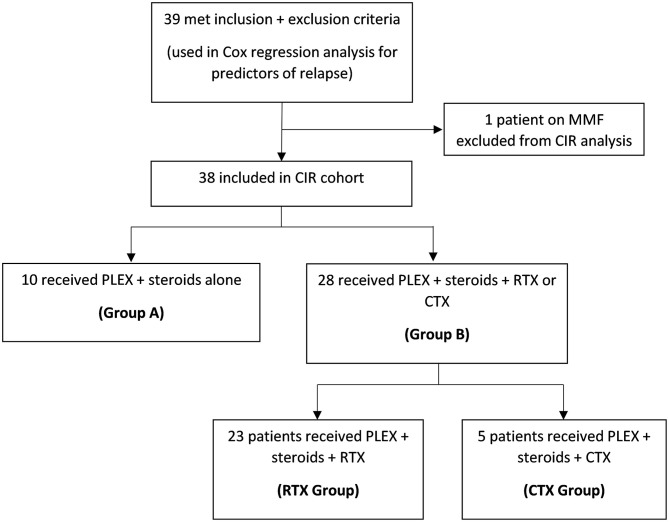
The four different groups used for CIR analysis.